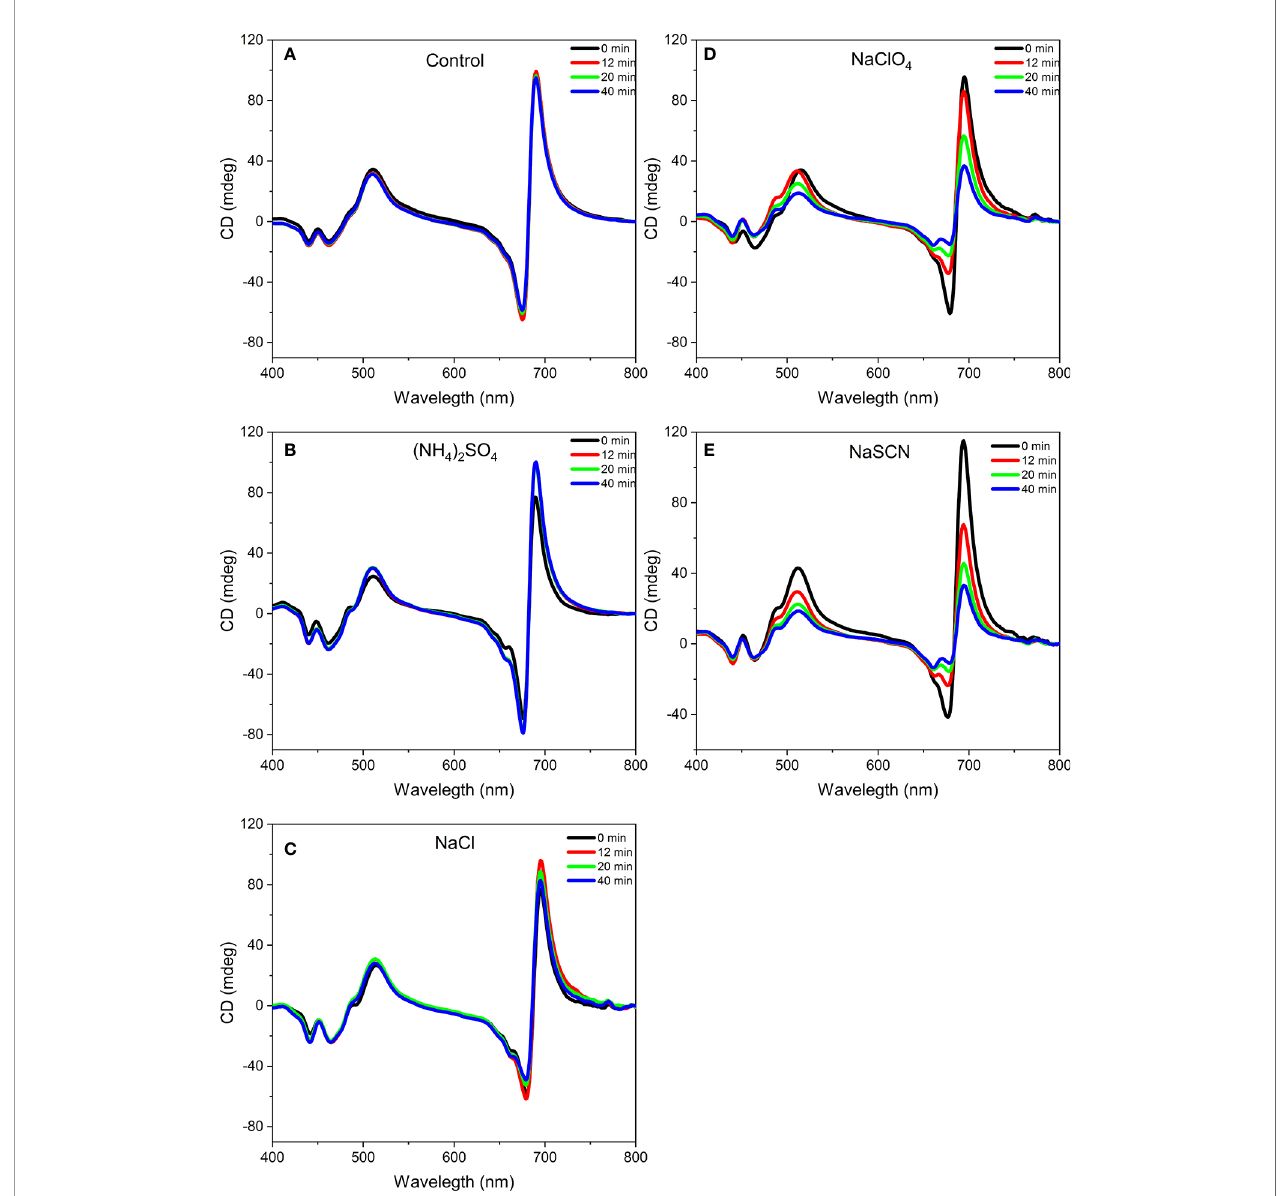
FIGURE 1 | Representative circular dichroism spectra of isolated pea thylakoid membranes without treatment (A) and before (0 min) and after (12, 20, and 40 min) of their treatments with 1 M (NH 4 ) 2 SO 2 (B) , 1 M NaCl (C) , 1 M NaClO 4 (D) , and 1 M NaSCN (E) . The spectra are normalized to the corresponding red absorbance maxima [OD(680 nm)=1.0] of the untreated samples. Note that the 12, 20, 40 min traces in (A) , and the 0 and 12 min traces in (B) , largely overlap. Five independent biological replicates were measured and a typical data set is